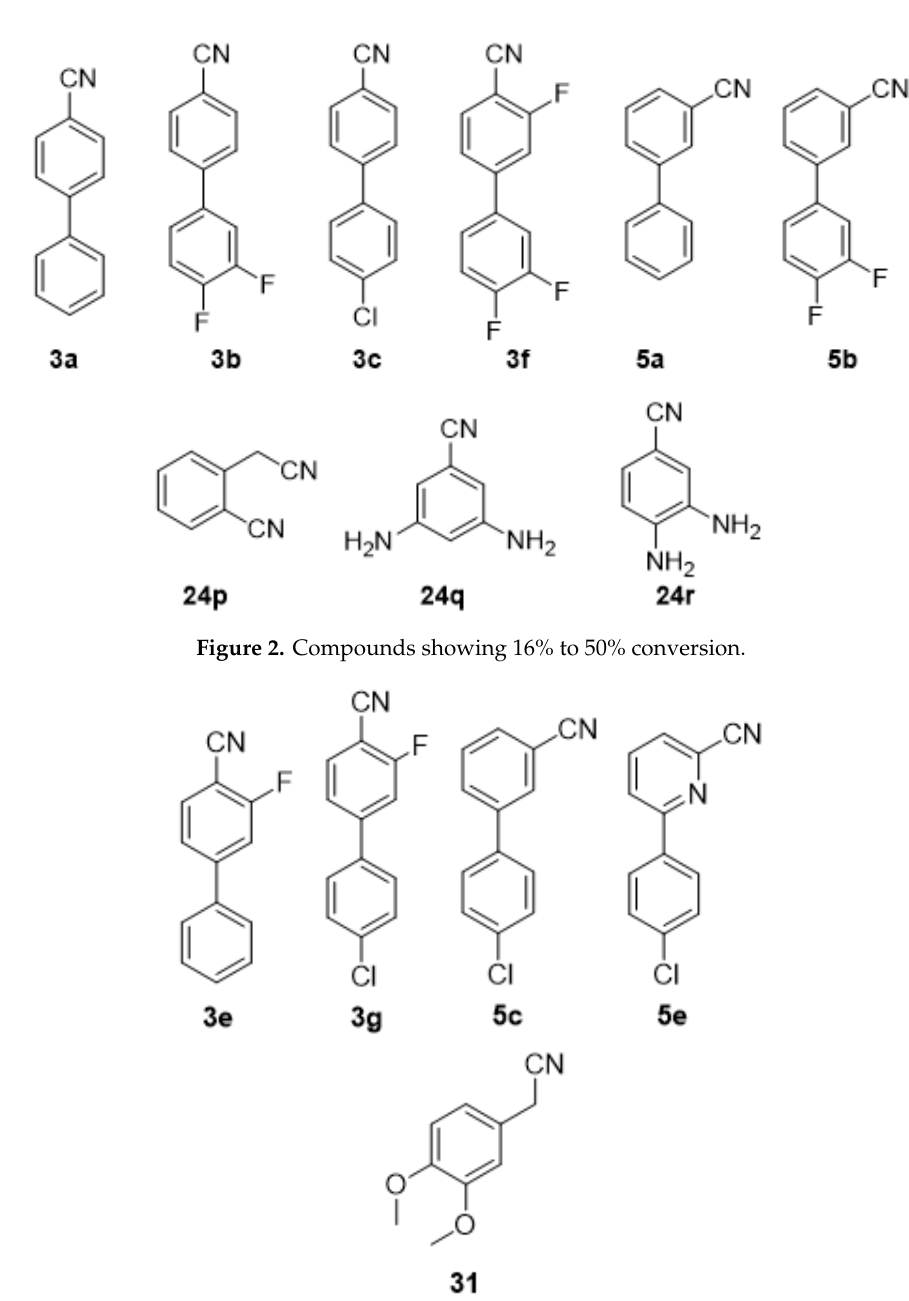
Figure 3. Compounds showing 5% to 15% conversion.